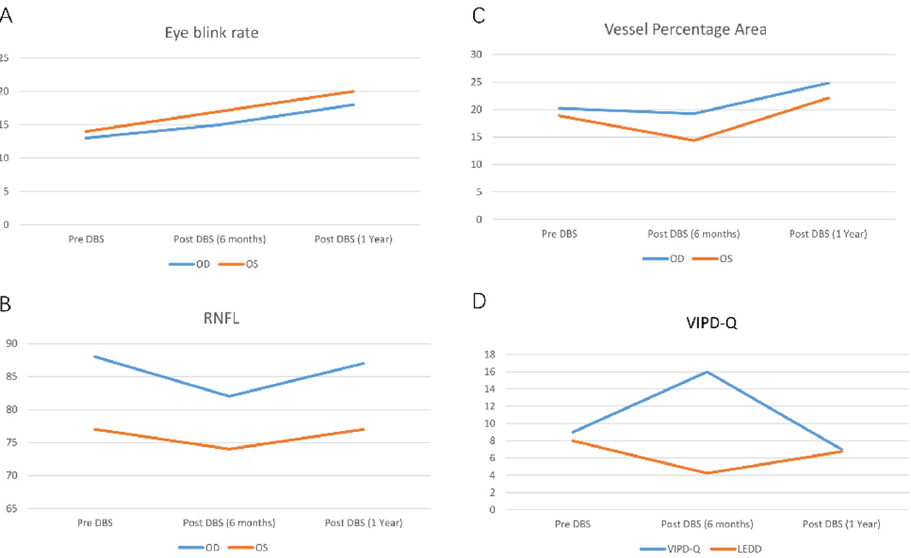
Figure 2. Fluctuation of ophthalmic characteristics pre ‐ and post ‐ STN ‐ DBS. ( A ) Eye ‐ blink rate. ( B ) RNFL. ( C ) Vessel percentage area. ( D ) VIPD ‐ Q.